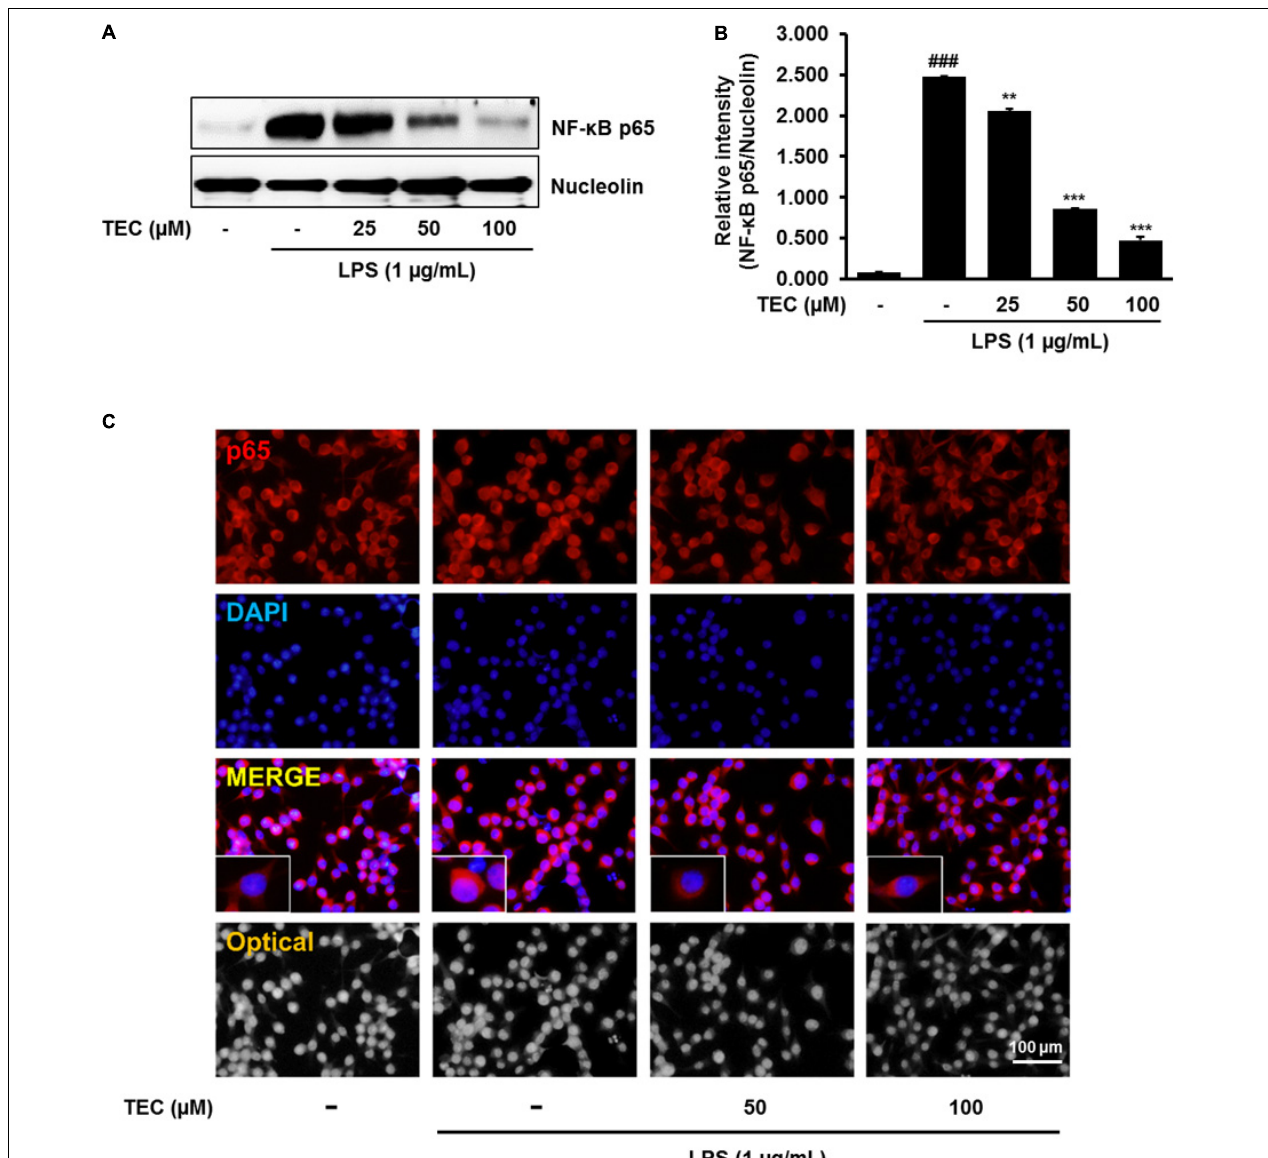
FIGURE 4 | TEC suppresses the activation of NF- κ B in LPS-stimulated BV-2 microglia. Cells were pre-treated with TEC for 1 h followed by LPS stimulation (1 µ g/mL) for 30 min. (A) Nuclear translocation of NF- κ B p65 was determined by western blot analysis. Nucleolin was use as a house keeping control gene for nuclear protein. (B) Bar graphs represent the relative expression of NF- κ B p65 for (A) . ### P < 0.001 vs. untreated control cells and ∗∗ P < 0.01 or ∗∗∗ P < 0.001 vs. LPS-treated cells. (C) Translocation of NF- κ B p65 into the nucleus was determined by Immunofluorescence analysis. Immunofluorescence microscope was used to detect the translocalization of NF- κ B p65 (red) and nucleus (blue). Scale bar: 100 µ